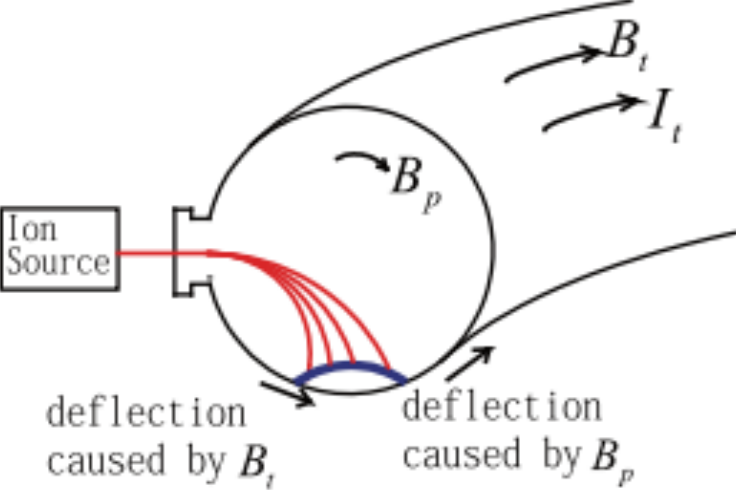
Figure 14. A diagram to show the concept of LITP. The traces of ions with different energy are shown